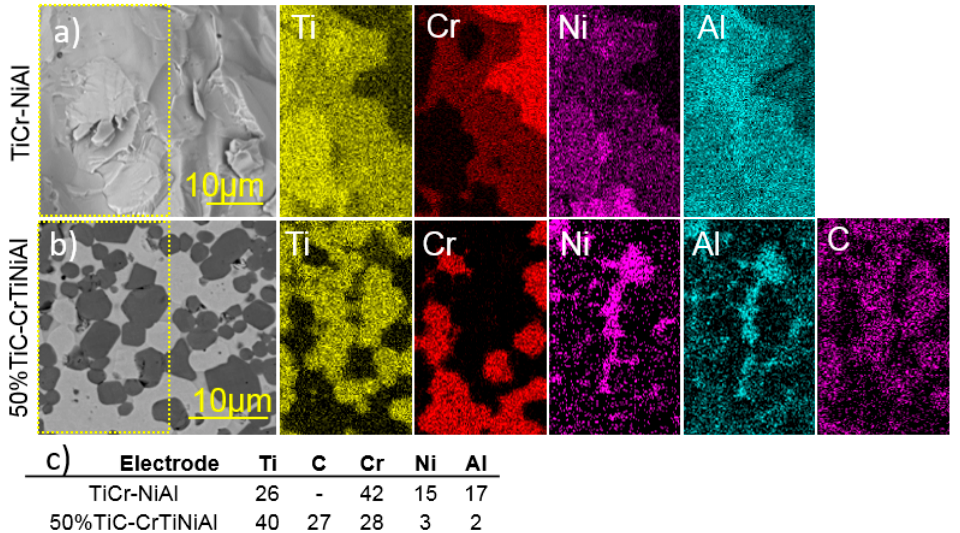
Figure 1. SEM images of TiCr-NiAl ( a ) and 50%TiC-CrTiNiAl ( b ) electrodes’ cross-sections with corresponding EDS element distribution maps and compositions of marked areas ( c ).